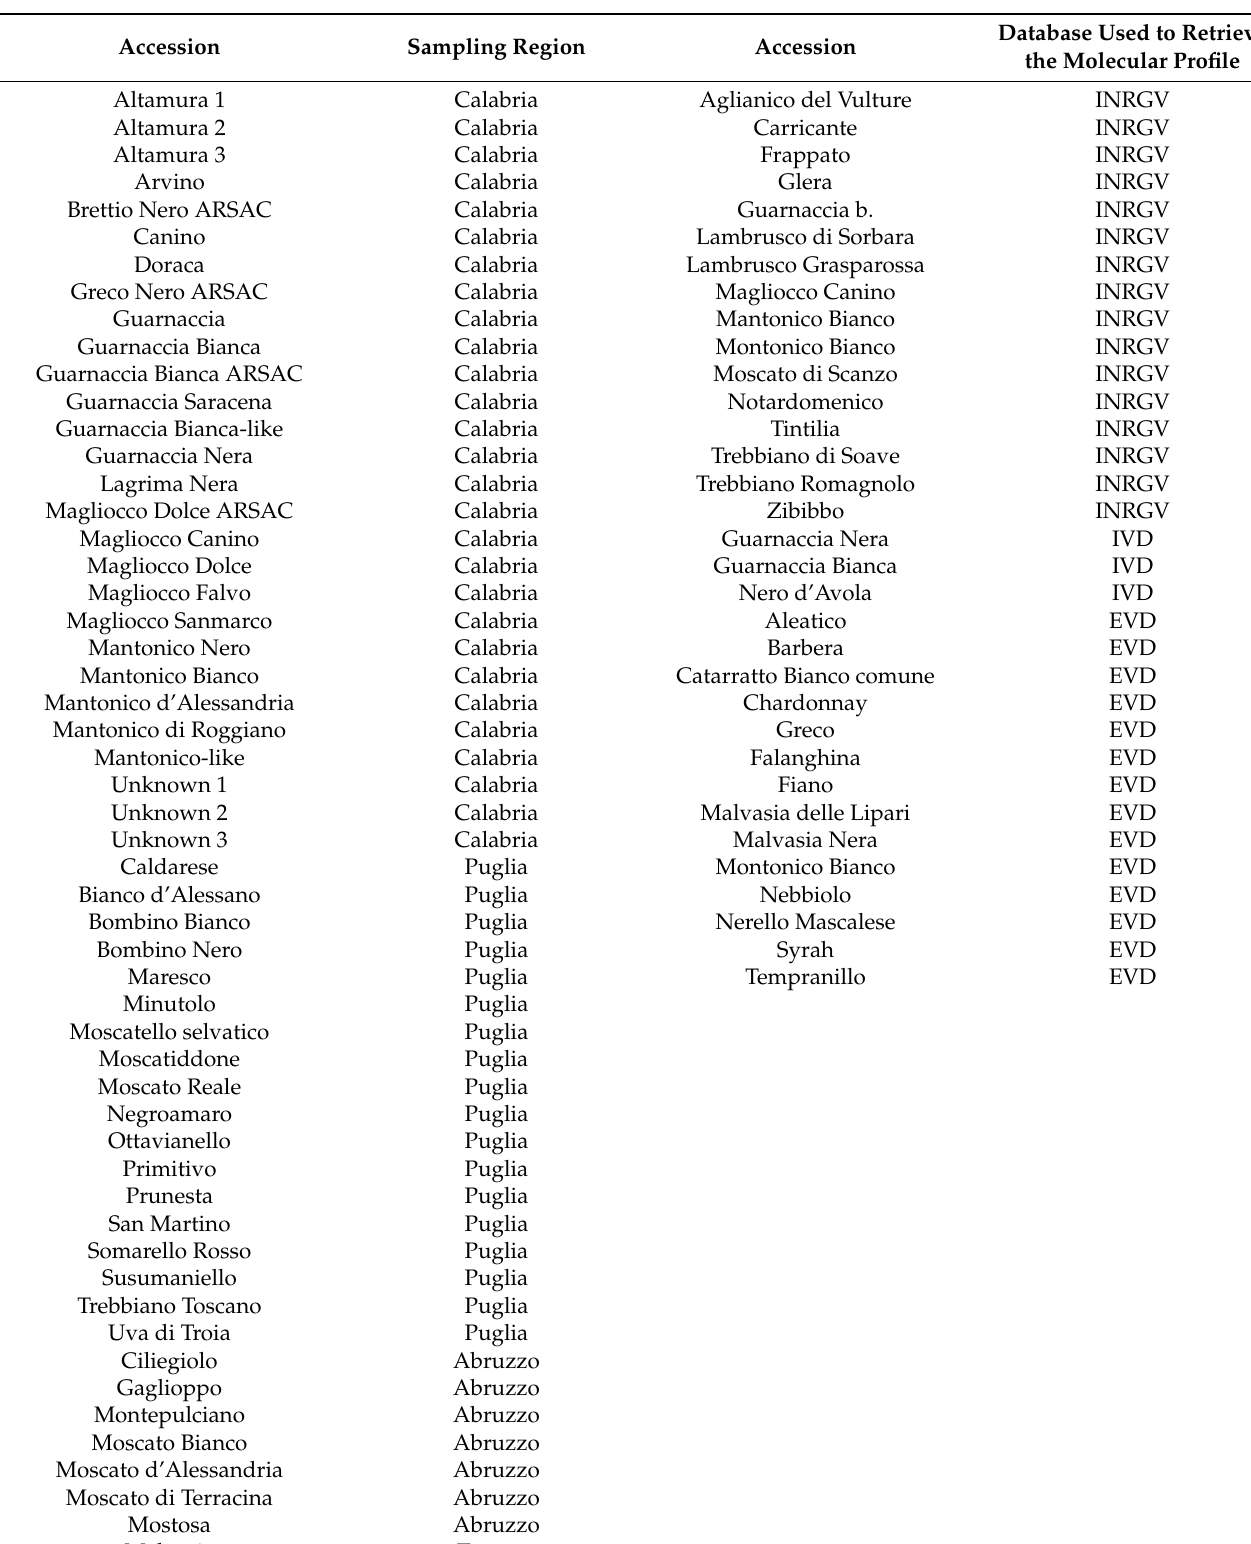
Table 1. List of accessions used for genetic diversity analysis. Sixty-four accessions were sampled in different Italian regions, while the profile of 33 varieties was retrieved from 3 molecular grapevine databases (INRGV = Italian National Registry of Grape Varieties; IVD = Italian Vitis Database; EVD = European Vitis